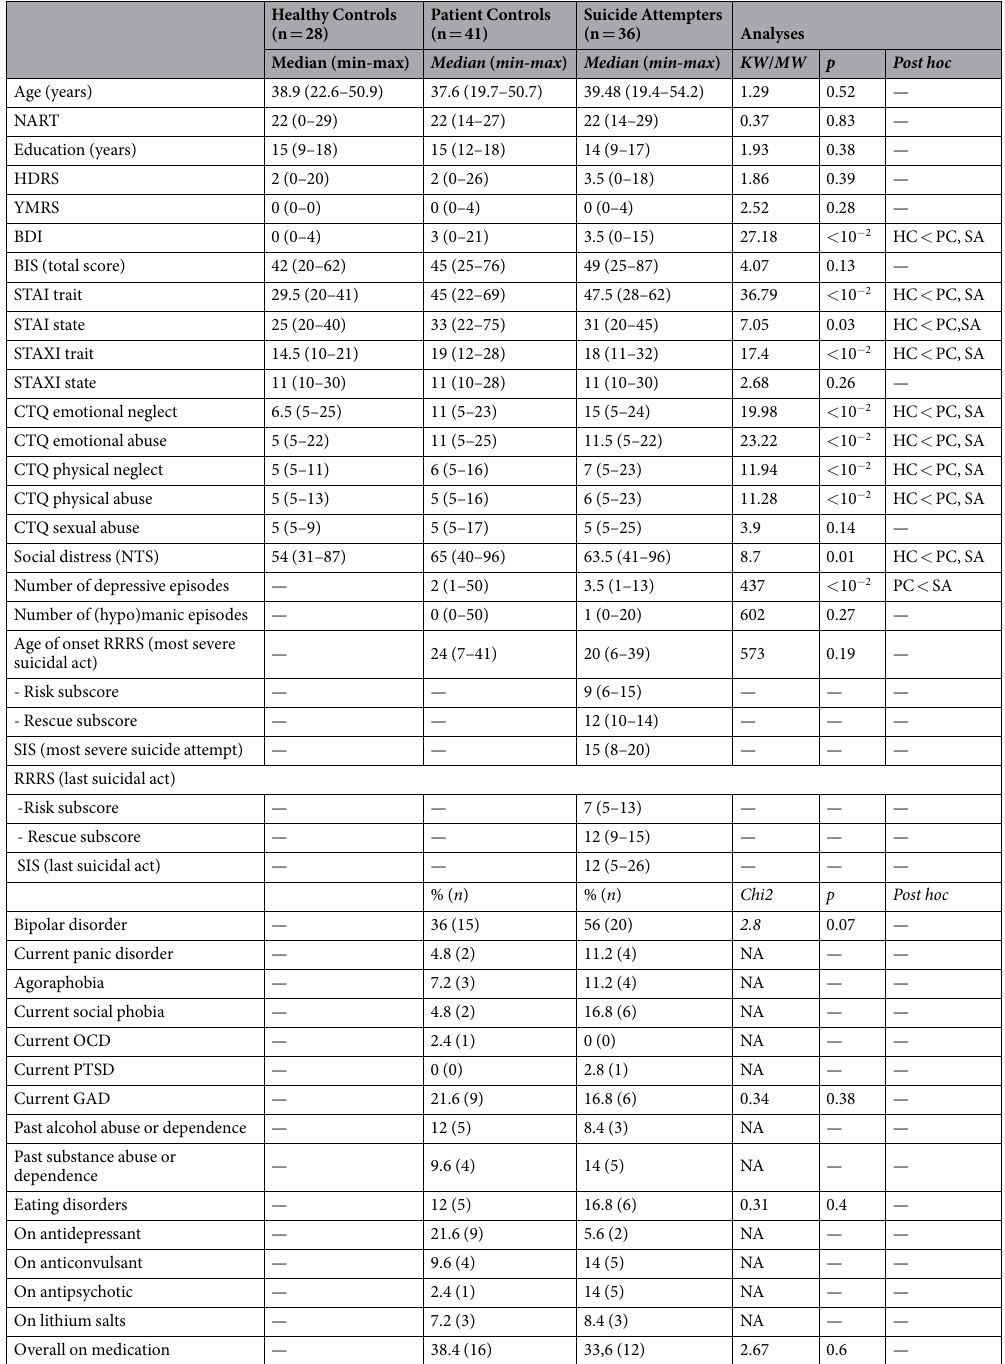
On antipsychotic — Table 1. Between-group comparisons for sociodemographic and clinical variables. Footnotes : HC = Healthy Controls; PC: Patient Controls; SA: Suicide Attempters; KW: Kruskal Wallis test; MW: Mann Whitney test; NART: National Adult Reading Test; HDRS: Hamilton Depression Rating Scale; YMRS: Young Mania Rating Scale; BDI: Beck Depression Inventory; BIS: Baratt Impulsiveness Scale; STAI: Spielberger State-Trait Anxiety Inventory; STAXI: Spielberger State-Trait Anger Inventory; CTQ: Childhood Trauma Questionnaire; NTS: Need Threat Scale; RRRS: Risk and Rescue Rating Scale; SIS: Suicide Intent Scale; OCD: Obsessive Compulsive Disorder; PTSD: Post Traumatic Stress Disorder; GAD: Generalized Anxiety Disorder; NA = Not